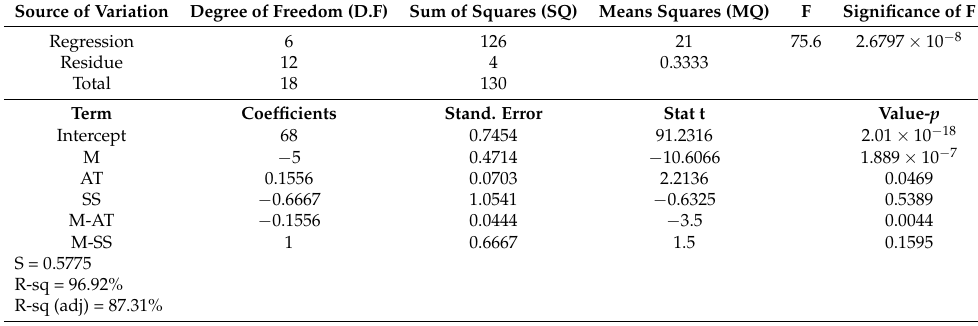
Table 6. ANOVA of factorial design for Shore D hardness (H).